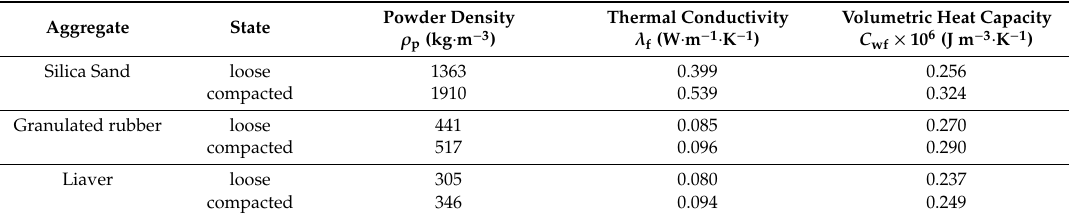
Table 3. Powder density and thermal properties of aggregates.